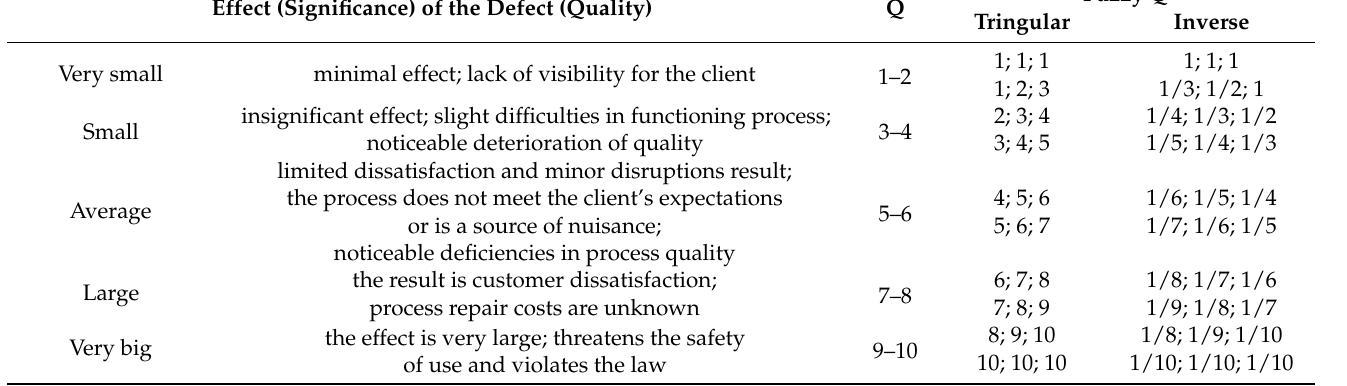
Table 3. Characteristic of assumed priority number Q—the effect (significance) of the defect (so-called quality). Own study based on